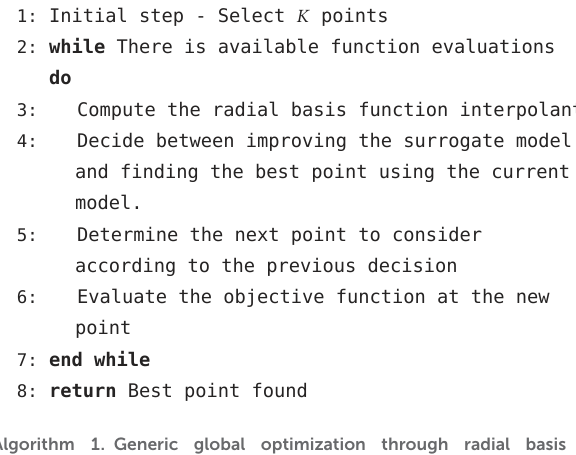
Algorithm 1. Generic global optimization through radial basis